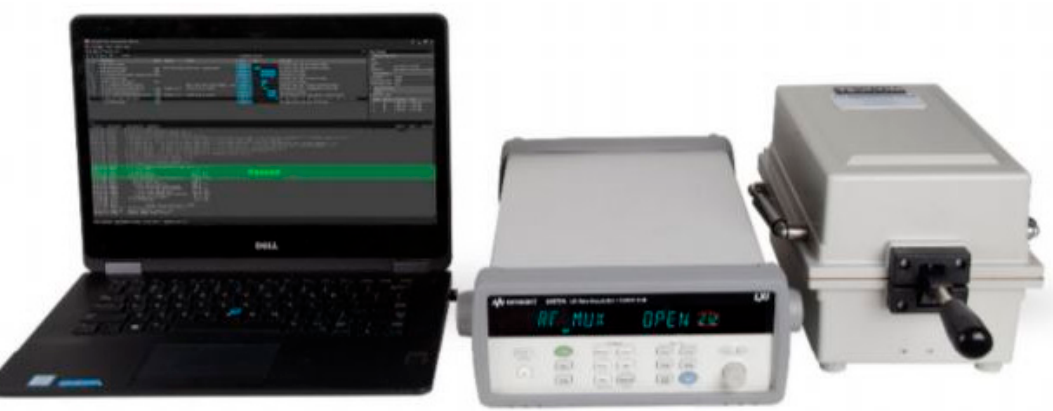
Figure 14. The test equipment for LoRa network. Sensors 2019 , 19 , x FOR PEER REVIEW